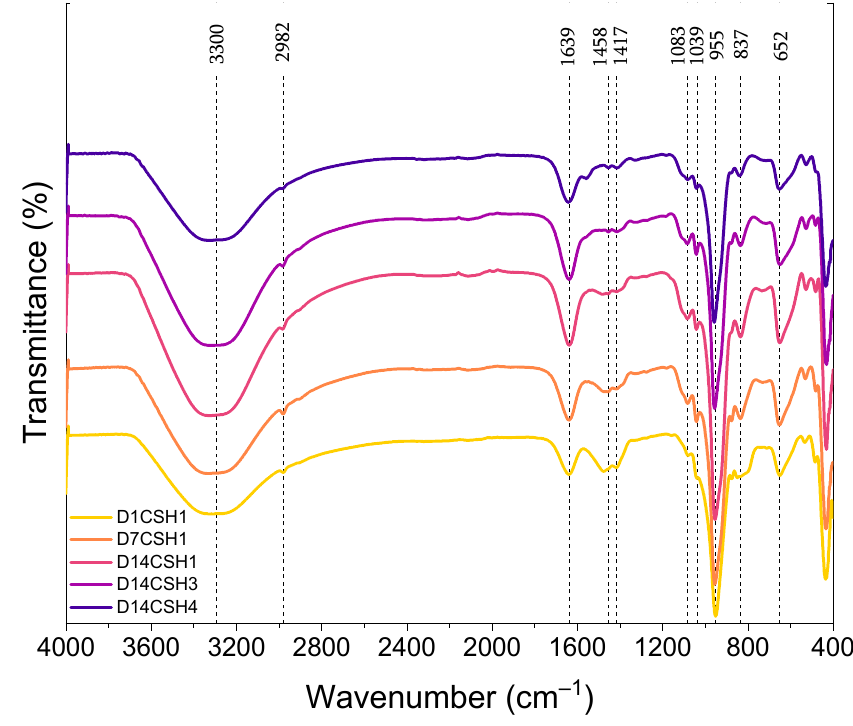
Figure 8. FTIR spectra of the CSH gels at different ages.